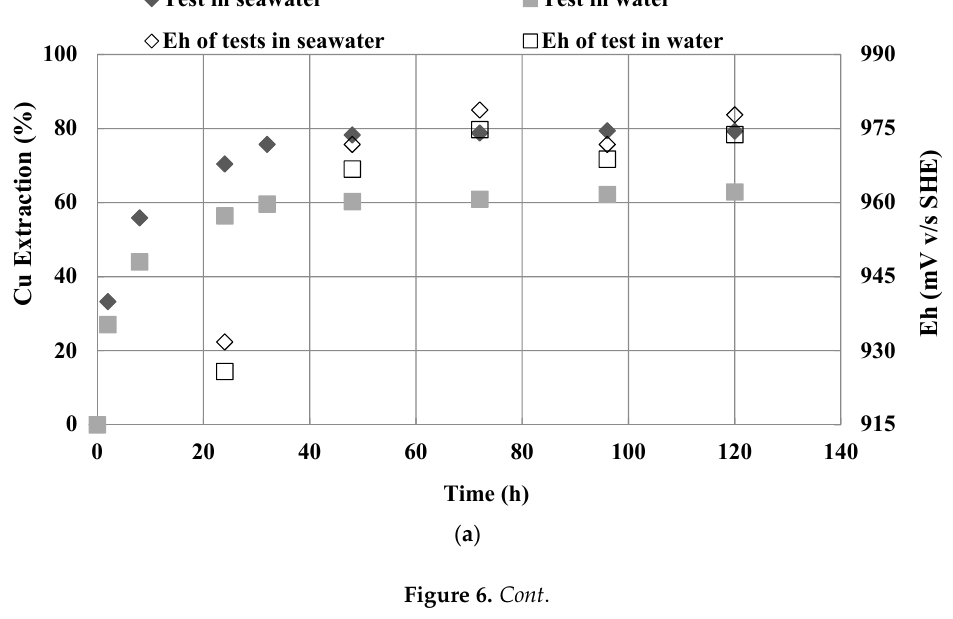
Figure 6. Cont Eh of test in water